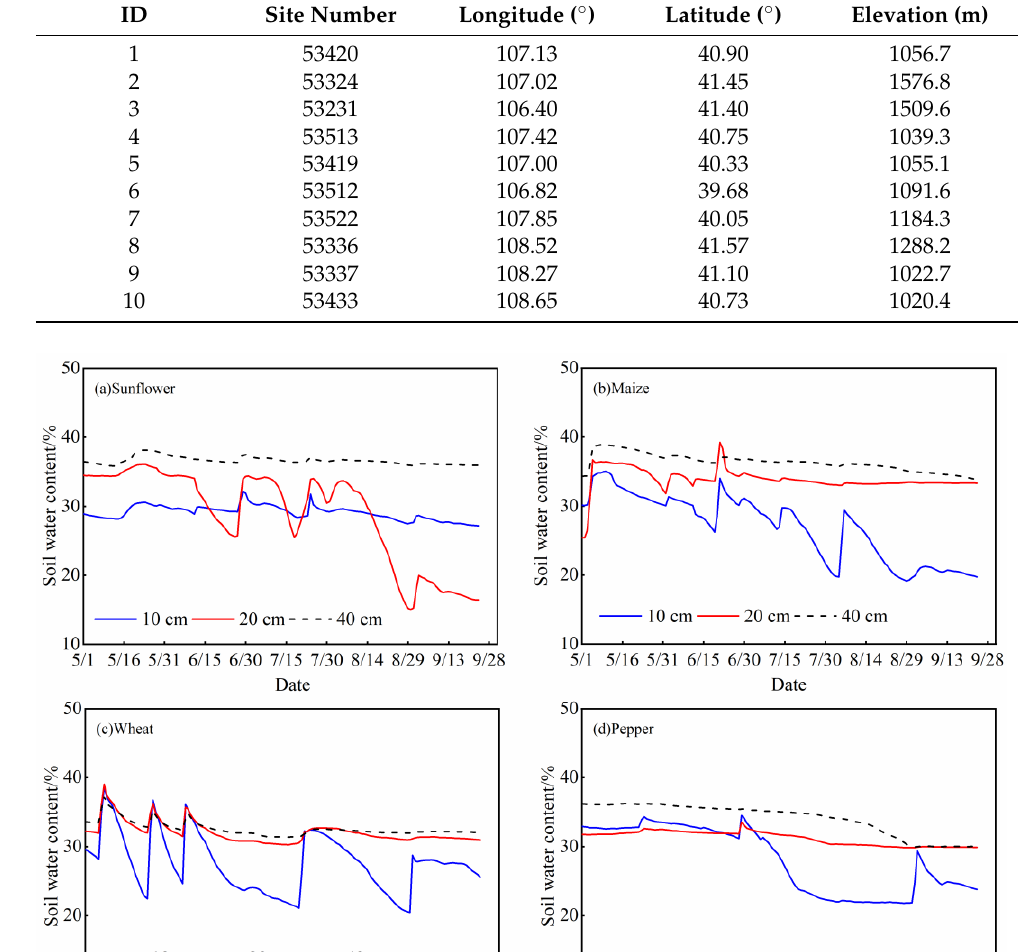
Table 1. Basic information about the meteorological stations.